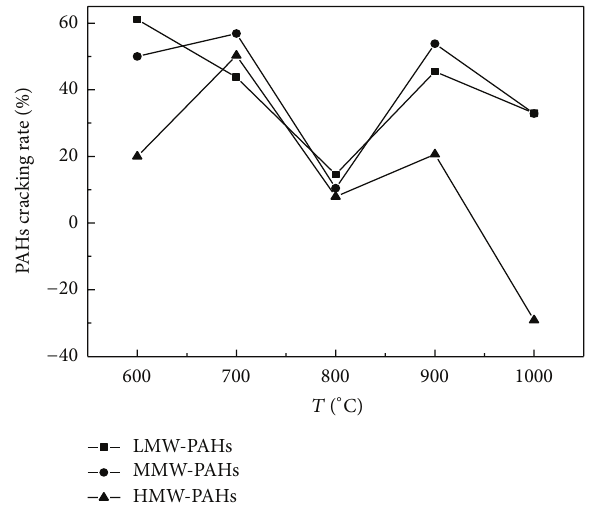
Figure 3: Relationship between the rings cracking rate distribution of PAHs and temperature under effect of Fe 2 O 3 .